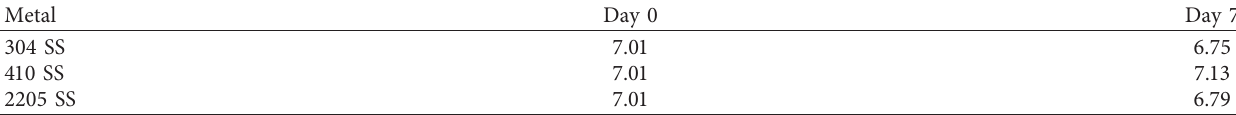
Table 4: Broth pH before and after incubation in 125 mL